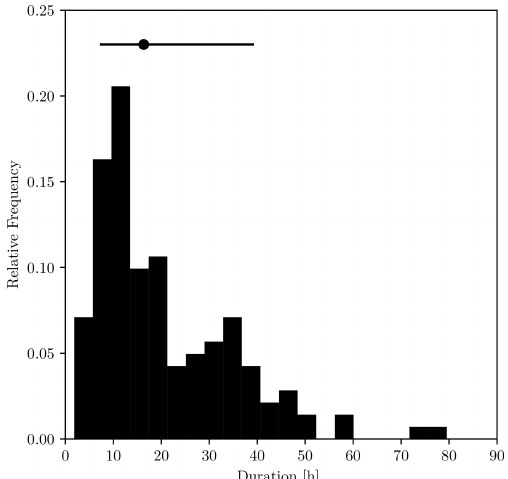
Figure 6. A histogram of the duration of pockets of open-cell stra- tocumulus is shown. The black dot above the histogram represents the median and the horizontal black line represents the 10th to 90th percentile